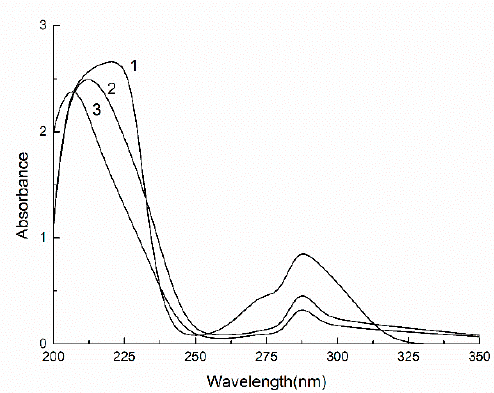
Figure 3. UV spectra of catechin standard (1), LOPC (2) and LPPC (3).